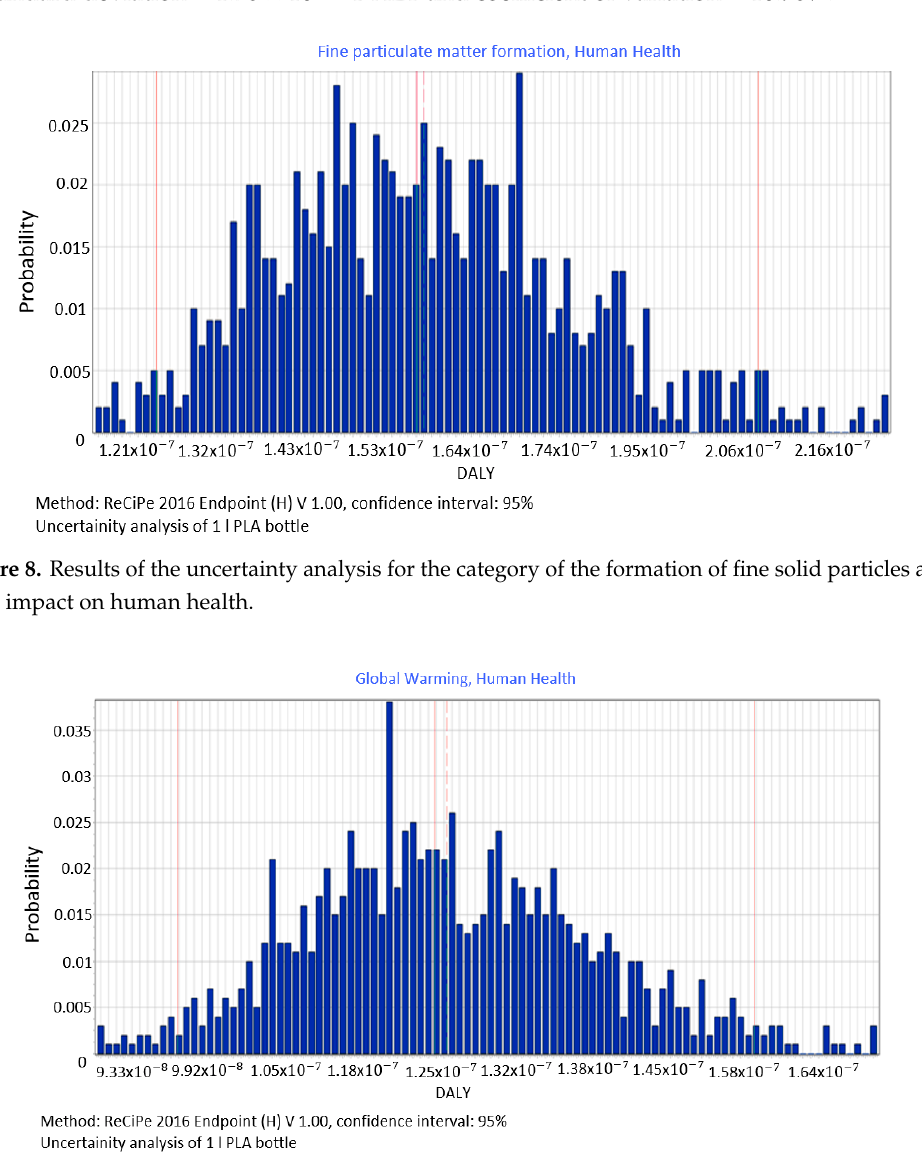
Figure 10. Results of the uncertainty analysis for the category of water consumption and its impact on human health. Analyses of stochastic data for all the stages of PLA bottle shaping also covered the emissions of compounds that cause damage in the area of ecosystem quality by contributing to global warming